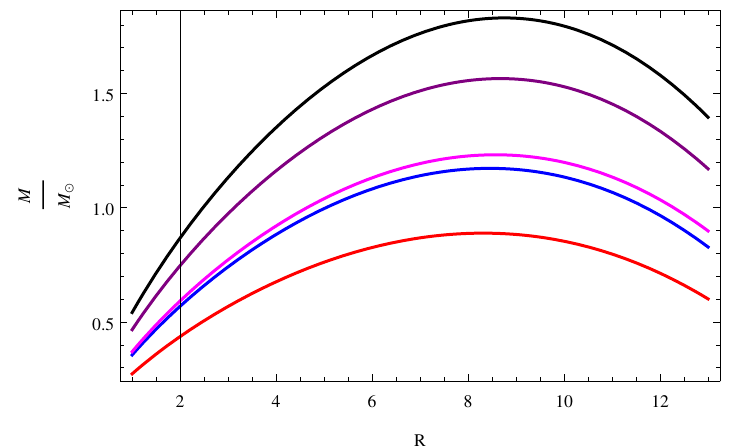
Figure 5. Plot of Mass ( M / M (cid:12) ) versus Radius ( R in km) curve for the strange star candidate LMC X − 4 due to different values of (cid:118) . The red, purple, magenta, blue and black colors represent respectively cases (cid:118) = 0, (cid:118) = 0.5, (cid:118) = 1, (cid:118) = 1.5 and (cid:118) =